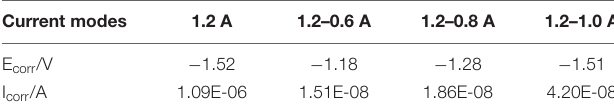
TABLE 5 | Electrochemical parameters from polarization